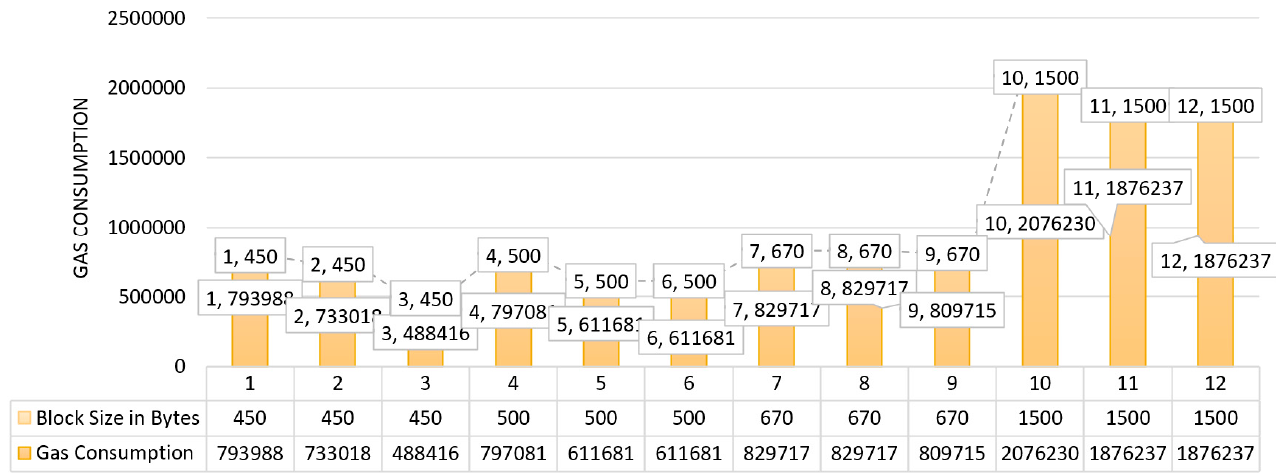
Figure 9. Gas consumption is based on transaction count and block size.